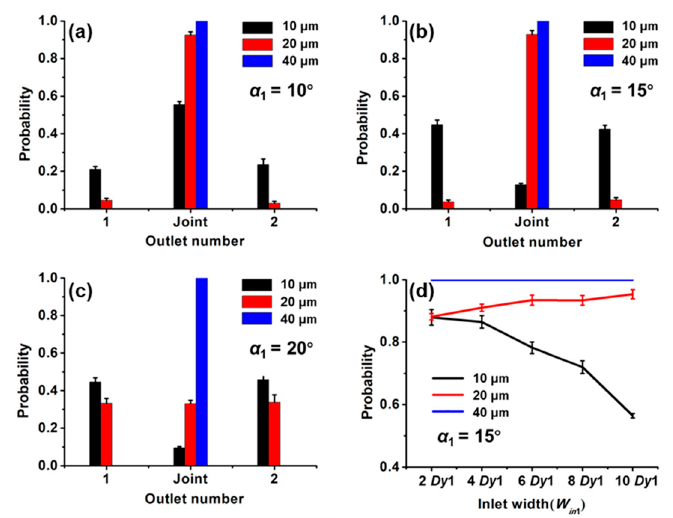
Figure 4. Probability distributions of the magnetic beads at the outlet of 1, Joint and 2 with the forcing angles of ( a ) 10°, ( b ) 15° and ( c ) 20° when the W in 1 = 2 Dy 1. ( d ) Probability distribution of magnetic beads at the outlet of 1, Joint, 2 for different W in 1 at α 1 = 15°.